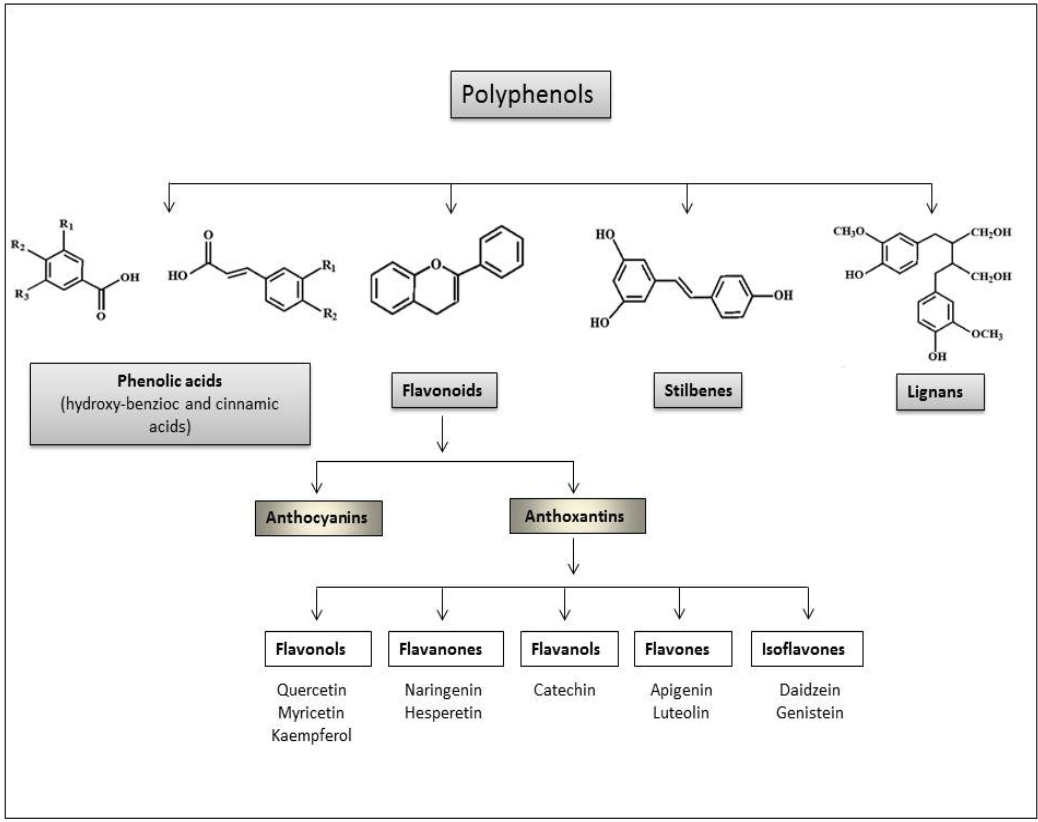
Figure 3. Classification and structure of the main polyphenols classes (adapted from